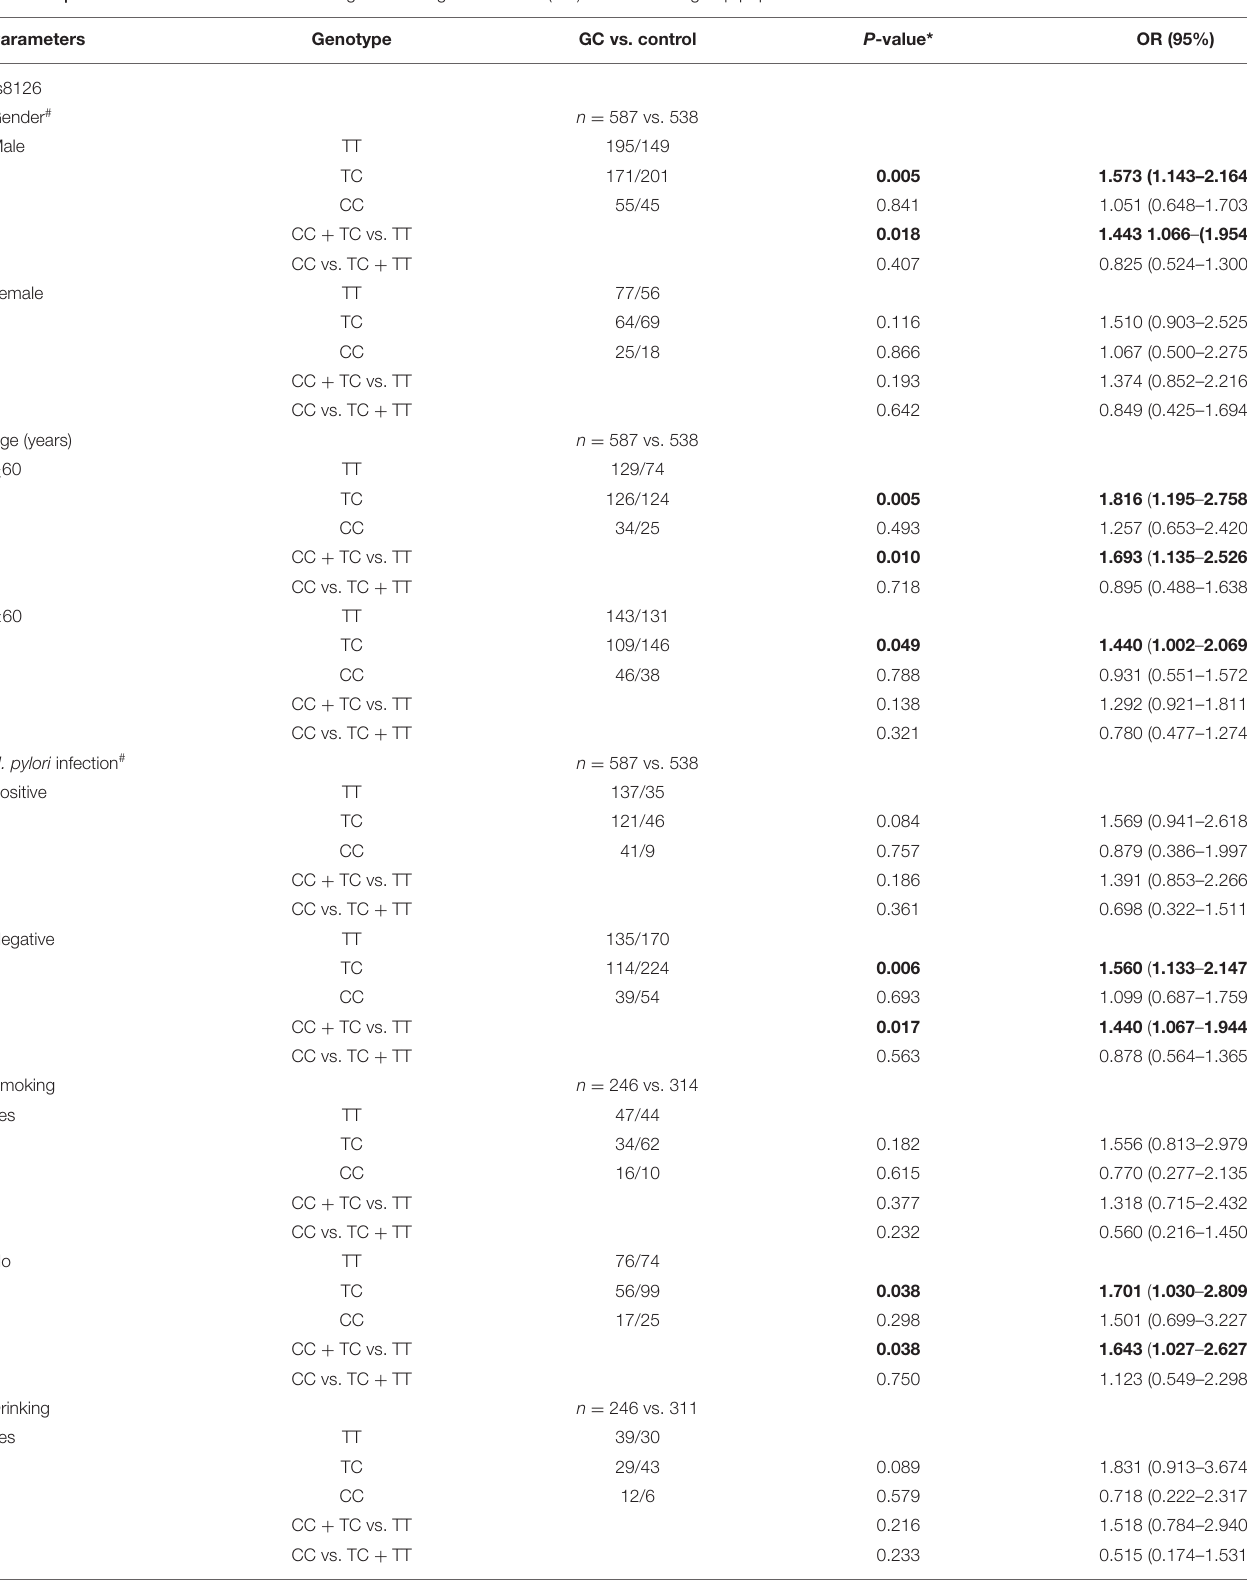
TABLE 3 | The correlation between TNFAIP2 TagSNPs and gastric cancer (GC) risk in the subgroup